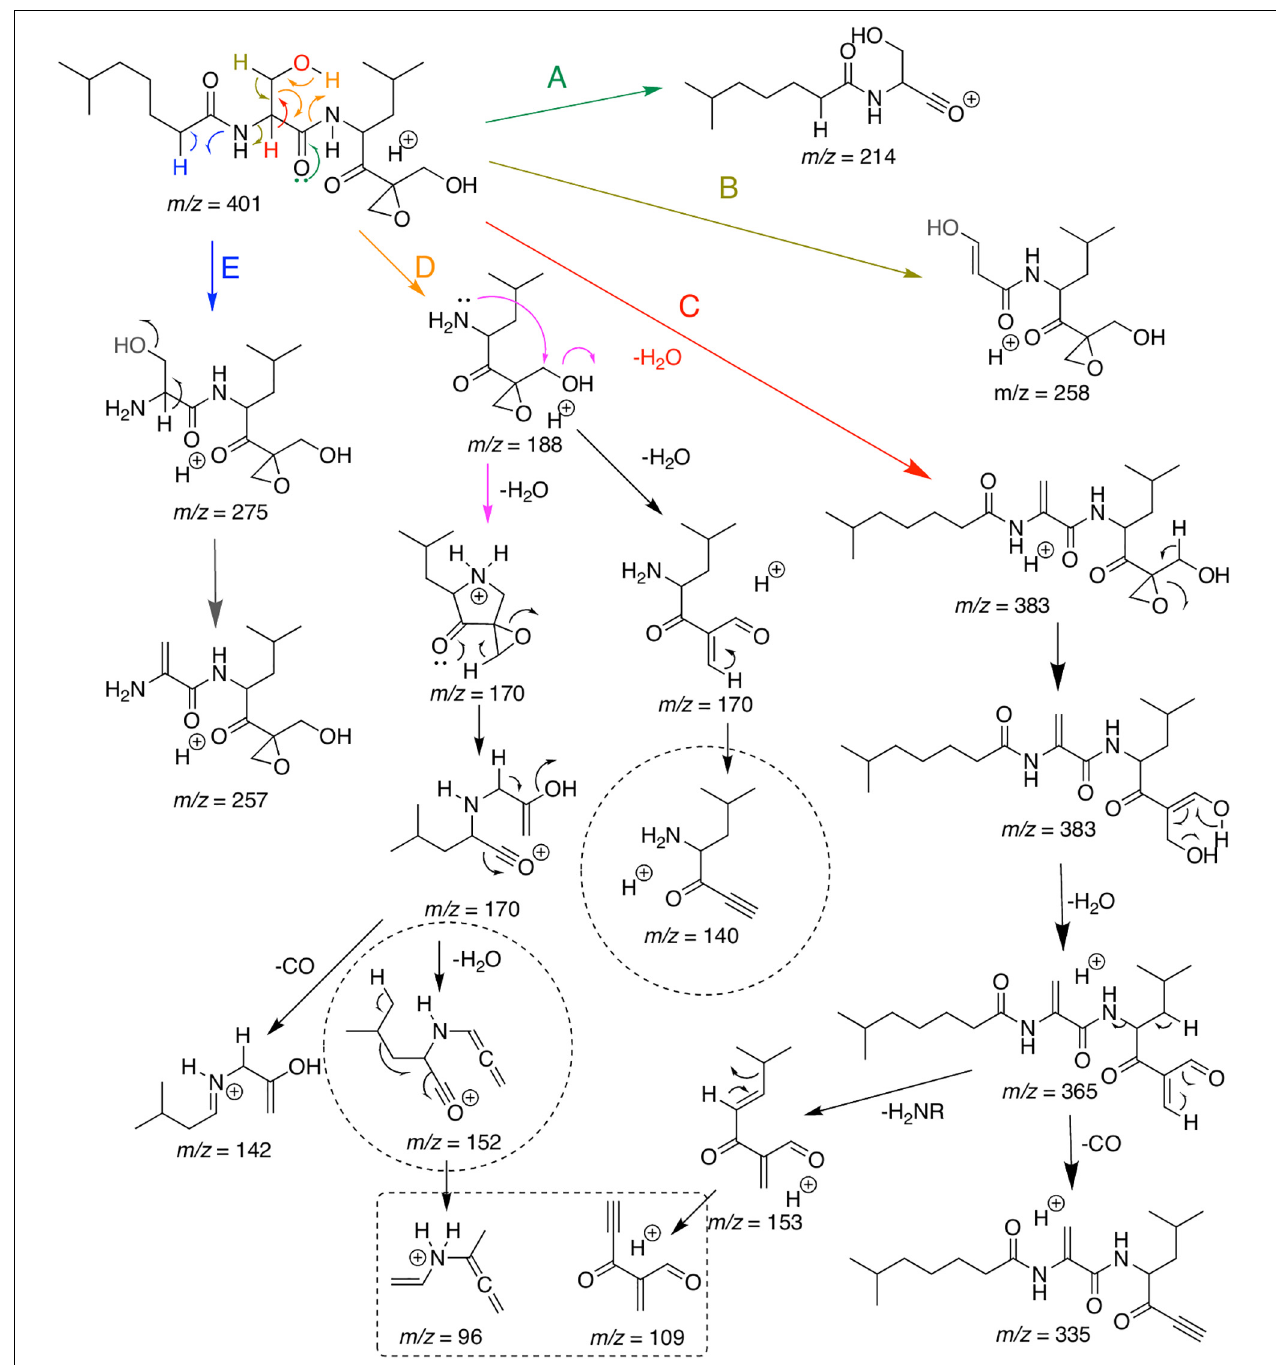
FIGURE 3 | Major putative ions detected in ESI-MS/MS analysis of a commercial standard dihydroeponemycin and the ion at (retention time) t R 12.0 min ( m/z 401). Analyses were carried out on Bruker Daltonic machines and the isolated protonated molecule was excited at a CID chamber applying N 2 as the collision